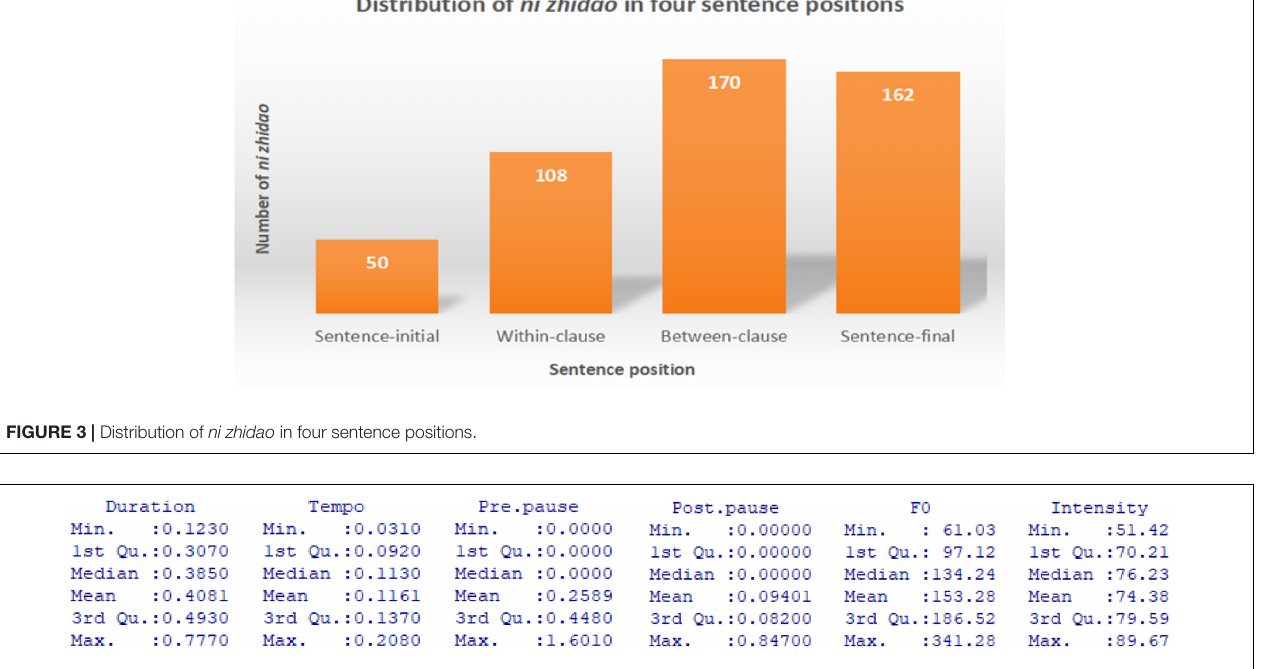
FIGURE 4 | Profile of values of prosodic parameters of ni zhidao in four sentence